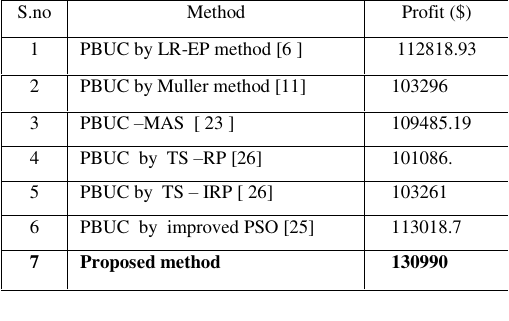
Comparison of the results of 10unit system (24Hr) with existing methods by proposed methodA